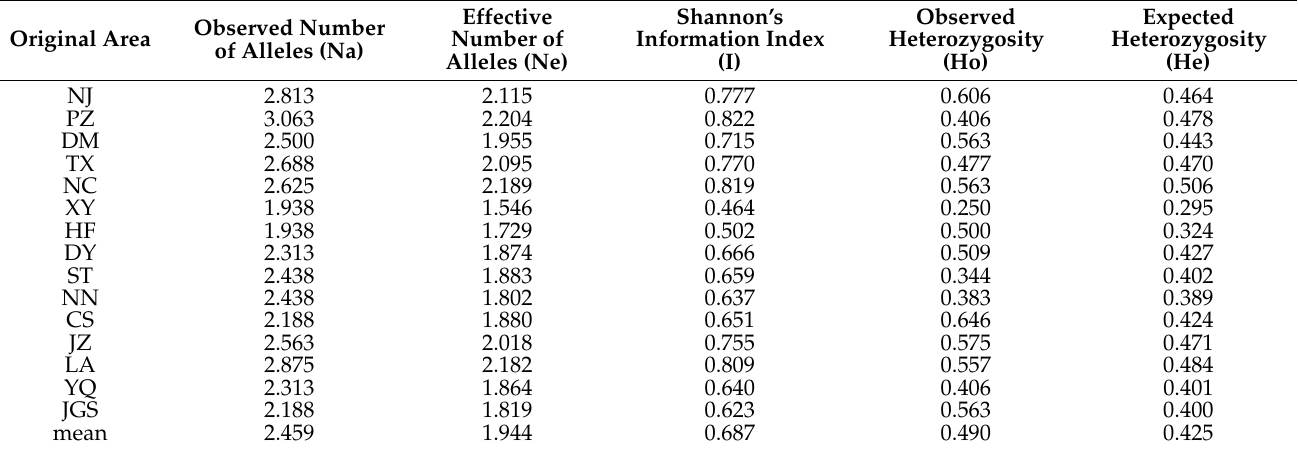
Table 3. Parameters of genetic diversity of 15 M. azedarach